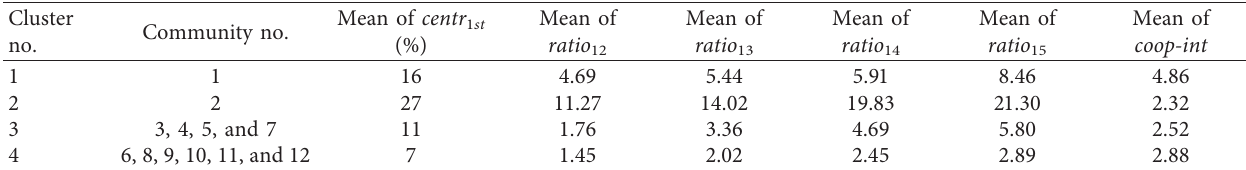
Figure 4: Plot of the total within the sum of the square with the number of Table 4: Group members of each cluster and their features.